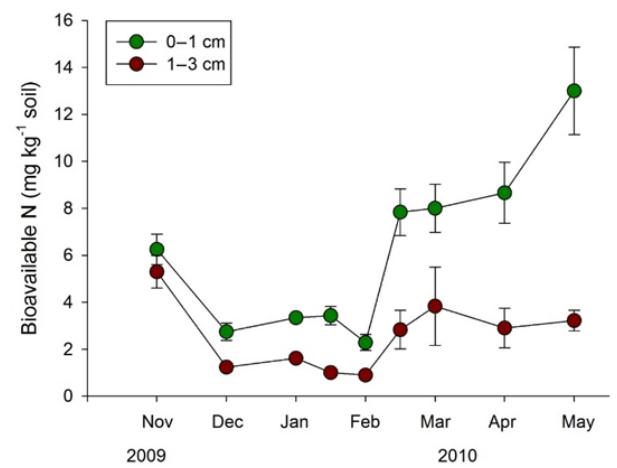
Figure 5. Seasonal trends to bioavailable N over 7 months (November–May 2009–2010) representing nine time periods (early and late January–February) for 0–1cm and 1–3cm depths; error bars represent standard error of the mean (SEM).